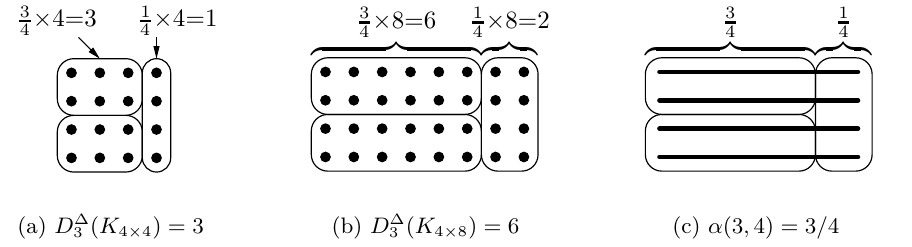
Figure 2: Graphical representations of D ∆ –colourings of (a) K 4 × 4 and (b) K 4 × 8 with the 3 same colouring pattern. The dots in each row of (a) and (b) represent the vertices of a partite set of K 4 × n , while a colour class is represented by means of a rectangular frame. In (c) a similarly structured normalised ∆( 3 , 3) 4 –partite colouring is given where the partite sets are viewed as line 4 segments of unit